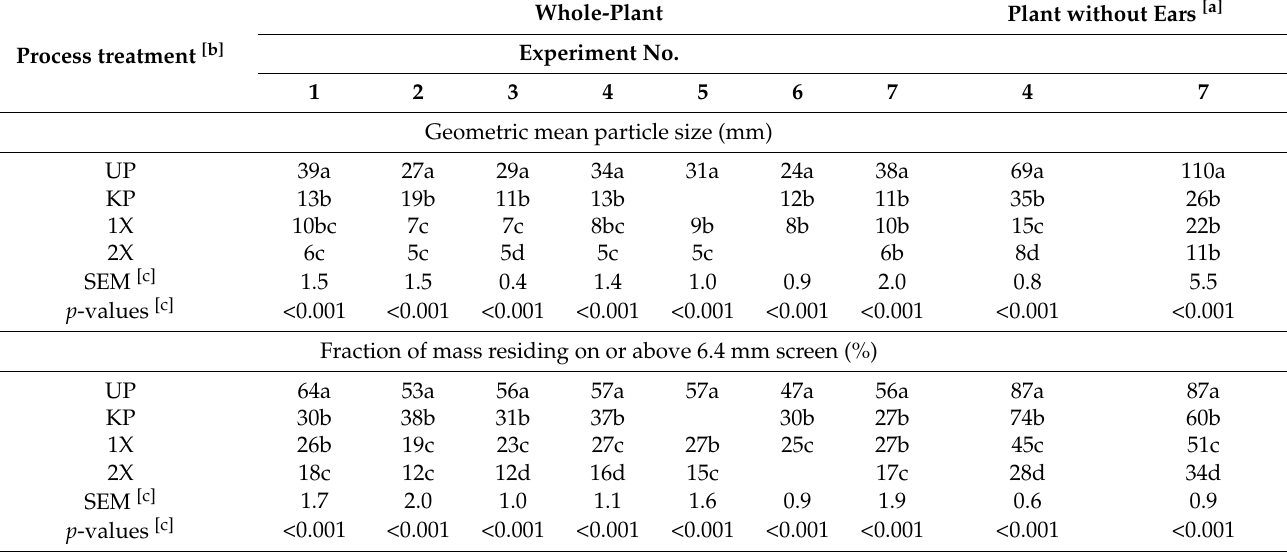
Table 3. Geometric mean particle size of whole-plant corn or corn plants without